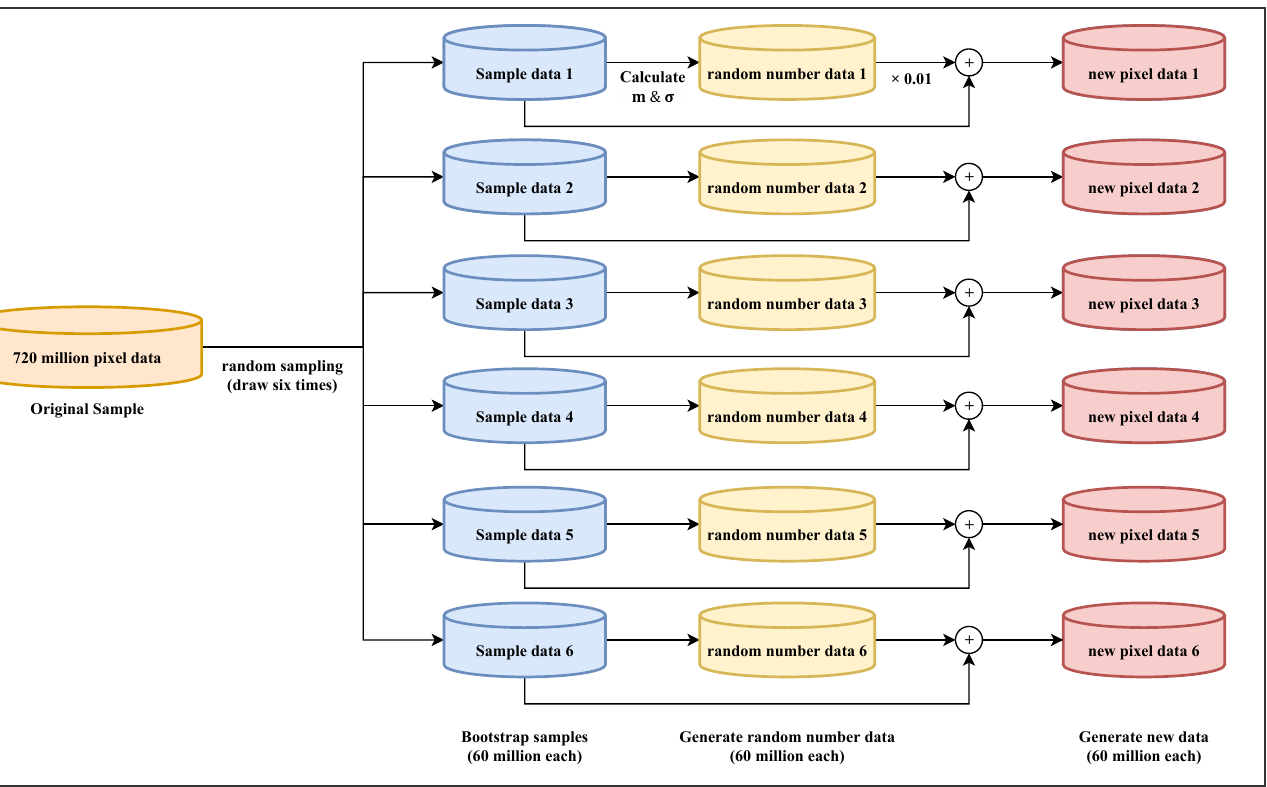
Figure 2. Bootstrap